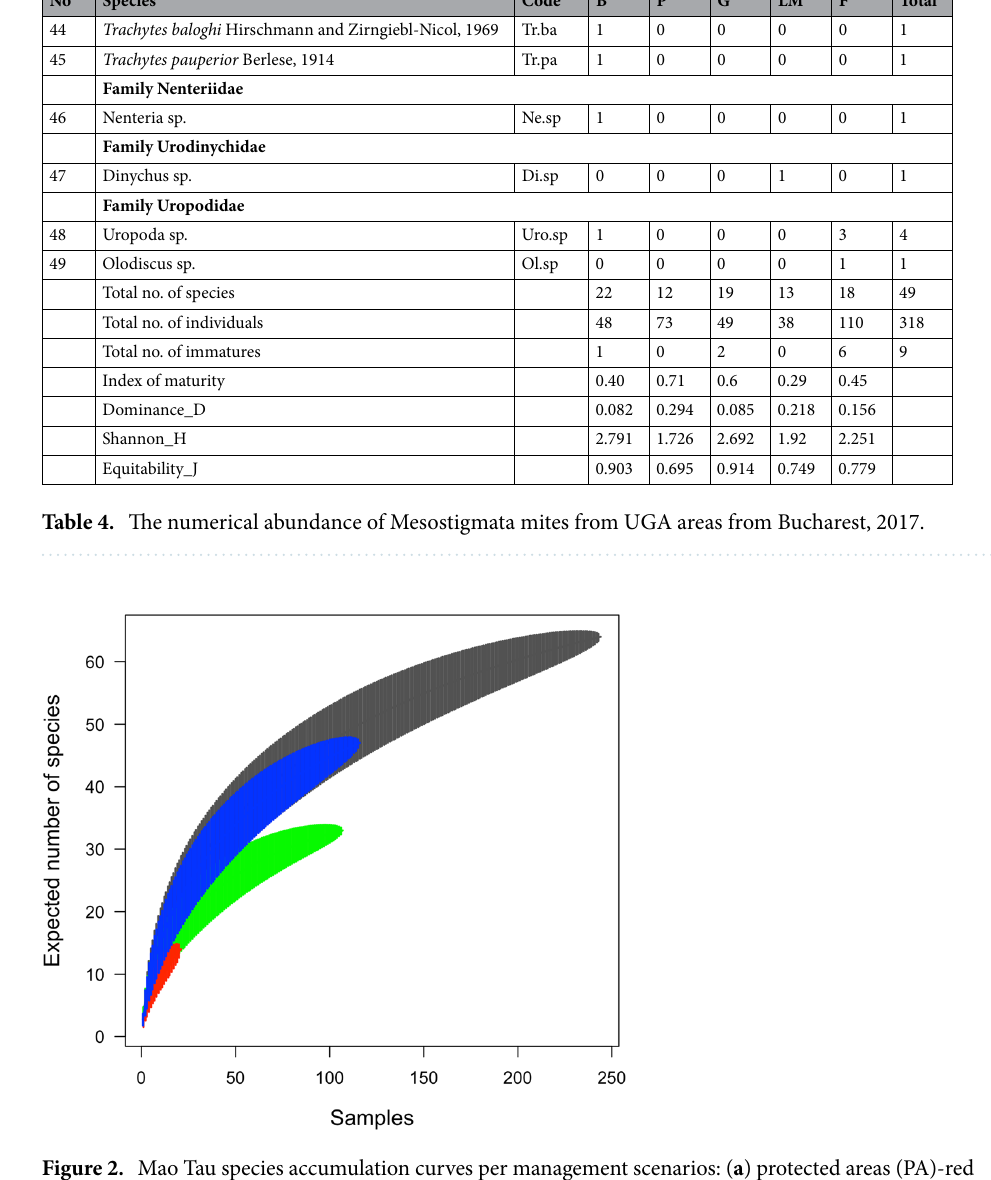
Figure 2. Mao Tau species accumulation curves per management scenarios: ( a ) protected areas (PA)-red colour, ( b ) managed green areas (MGA)-green colour, ( c ) unmanaged green areas (UGA)—blue colour, and ( d ) for all sites—grey